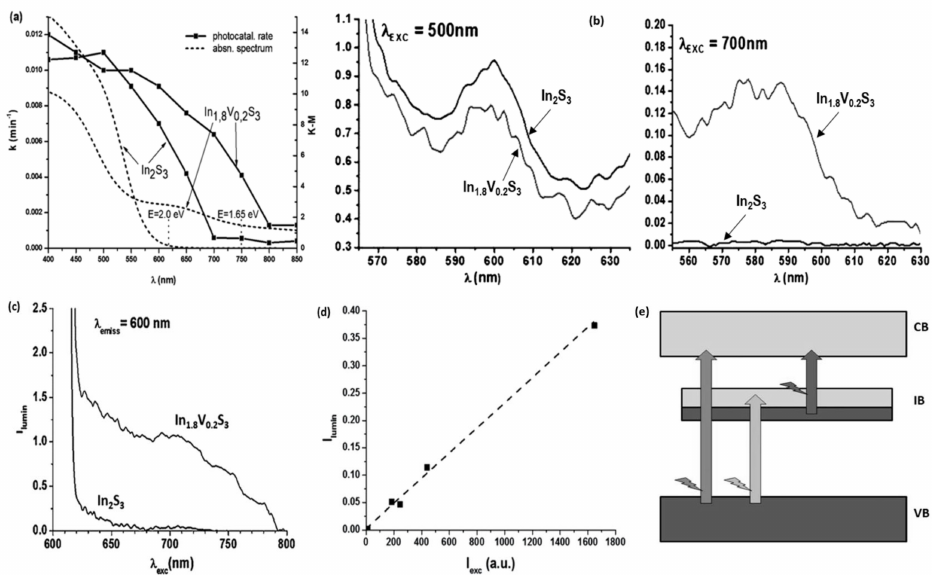
Figure 5. ( a ) Spectral response of aqueous formic acid degradation of V-containing In 2 S 3 , compared with that of V-free In 2 S 3 and with their respective absorption spectra. ( b ) PL tests using wavelengths above and below the bandgap energy; only V-containing In 2 S 3 can excite PL at near 600 nm, while In 2 S 3 cannot. ( c ) PL range in which emission at λ = 600 nm is excited only by V-containing In 2 S 3 . ( d ) Linear relationship between excitation intensity and resulting photoluminescence, which is in agreement with ( e ) (Adapted from Ref. [132]).